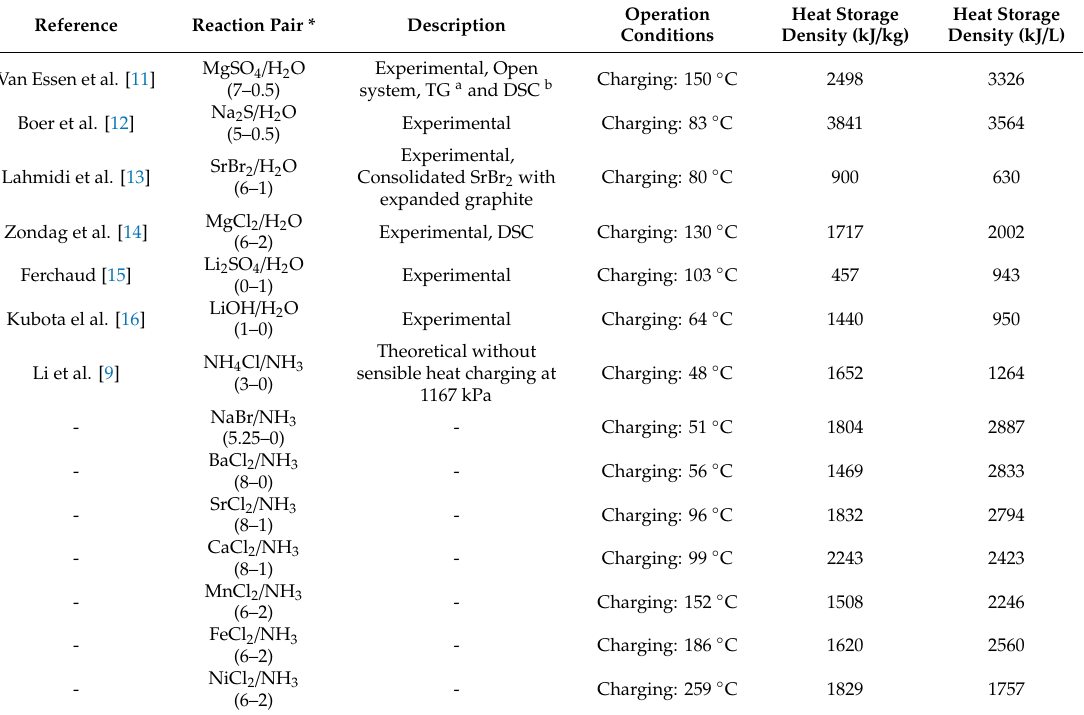
Table 1. Energy storage density of di ff erent